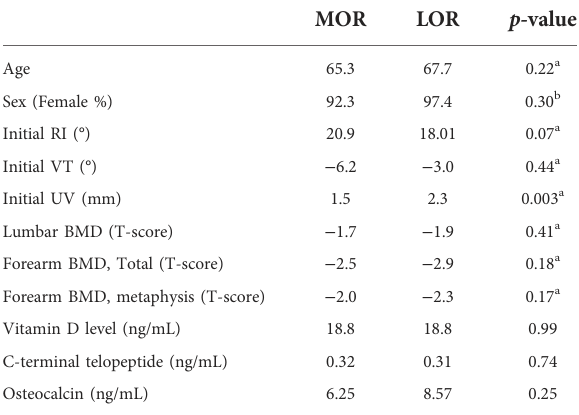
TABLE 1 Comparison between the maintenance of reduction (MOR) group and the loss of reduction (LOR)